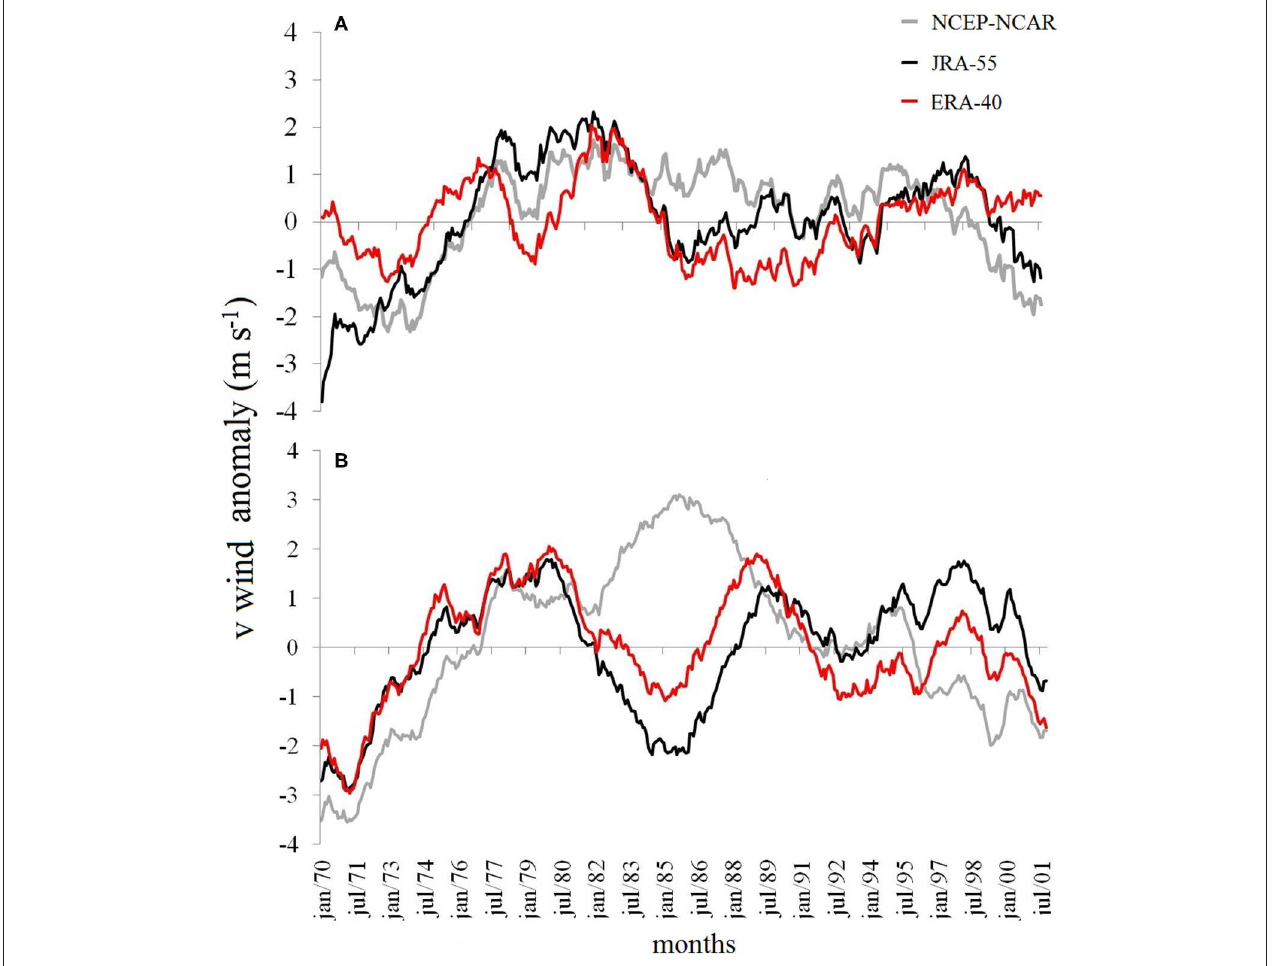
FIGURE 7 | Monthly meridional wind component averaged over (62 ◦ W, 25 ◦ S; 58 ◦ W, 18 ◦ S), where LLJ commonly assumes higher values (over Bolivia and Paraguay), at (A) 250 hPa and (B) 850 hPa, in the 1970–2001 period, for NCEP-NCAR (gray), JRA-55 (black) and ERA-40 (red) datasets.